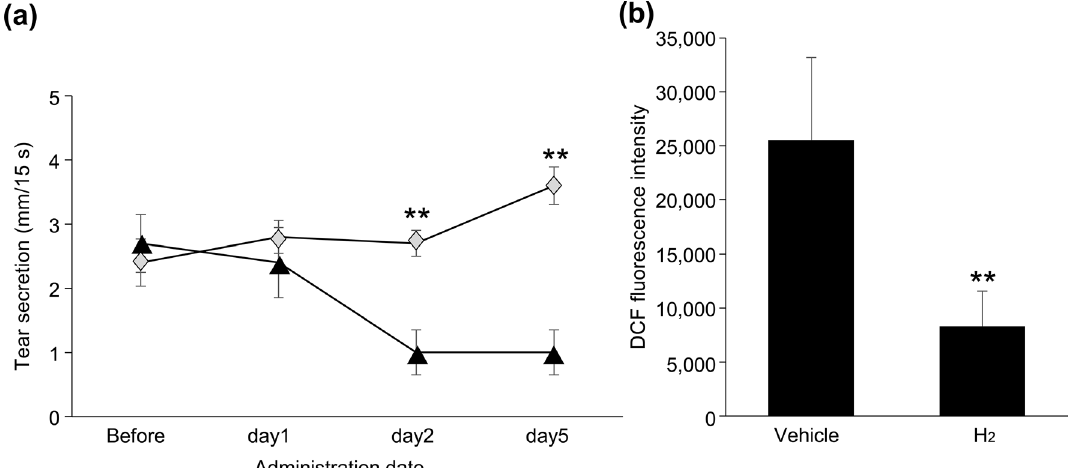
Figure 5. Evaluations of the stress-induced dry eye murine model. ( a ) Measurement of tear secretion using the average value for the left eyes in the stress-induced dry eye model. ( b ) Quantitative measurement of the reactive oxygen species in the lacrimal gland in the stress-induced dry eye model. All results are expressed as the mean ± standard deviation (n = 5). Significant differences from the vehicle group are indicated by ** p < 0.01 . DCF dichlorofluorescein. Black triangle: vehicle, grey diamond: SUPER H2 (molecular hydrogen; H 2